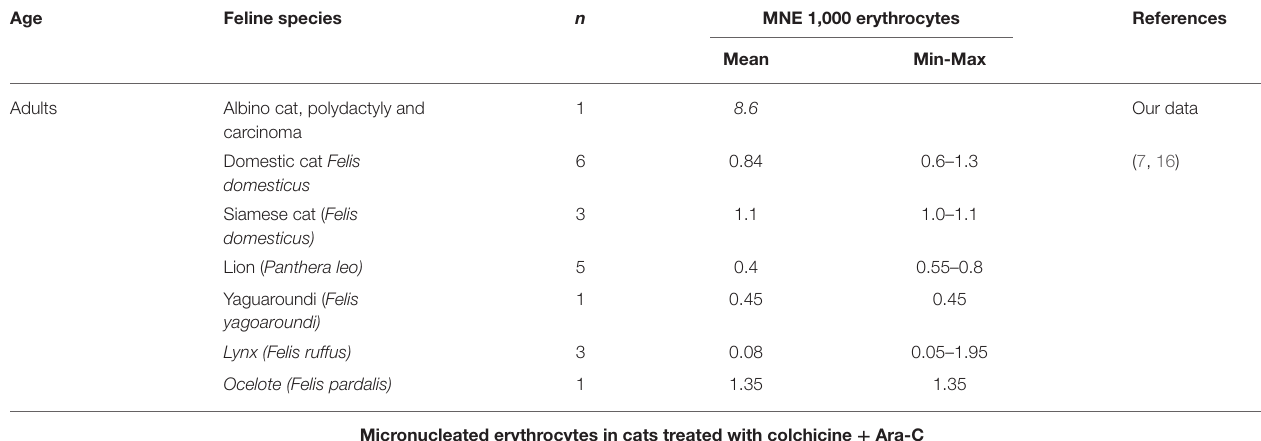
TABLE 2 | Micronucleus frequency in the feline peripheral blood.